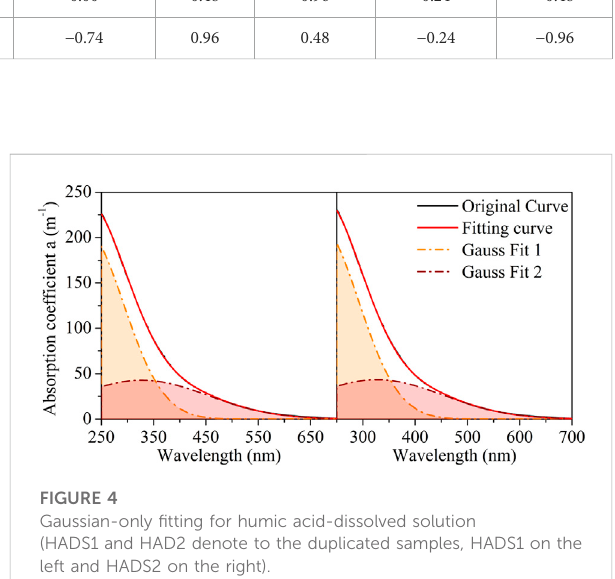
FIGURE 3 Gaussian-only fi tting for lignin-dissolved solution (LDS1 and LSD2 denote to the duplicated samples, LDS1 on the left and LDS2 on the right).